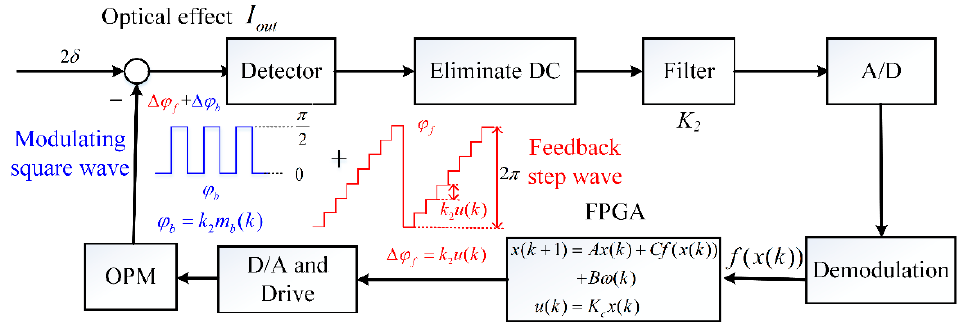
Figure 2. The detection scheme of closed-loop OVS.